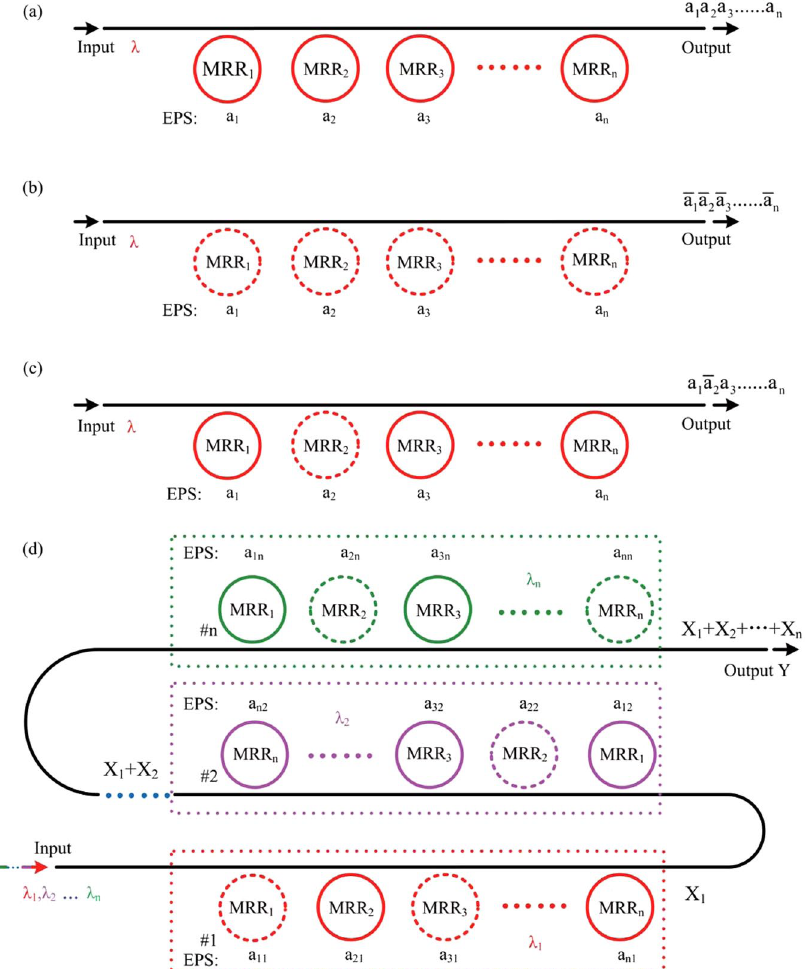
Figure 2. The logic circuit with ( a ) one working wavelength and all MRRs work in the block / pass mode, ( b ) one working wavelength and all MRRs work in the pass / block mode, ( c ) one working wavelength and MRRs work in the pass / block or block / pass mode, and ( d ) the proposed reconfigurable logic circuit (the solid line ring denotes MRR working in the block / pass mode, the dot line ring denotes MRR working in the pass / block mode, MRRs with the same color work at the same working wavelength, EPS: electrical pulse sequences).